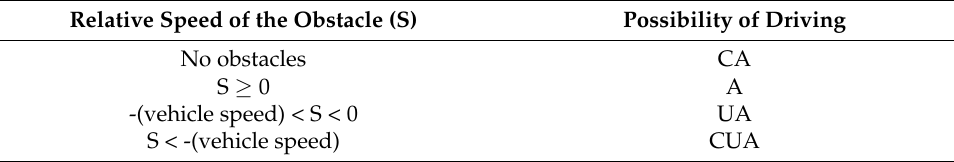
Table 2. Driving possibility according to object speed.